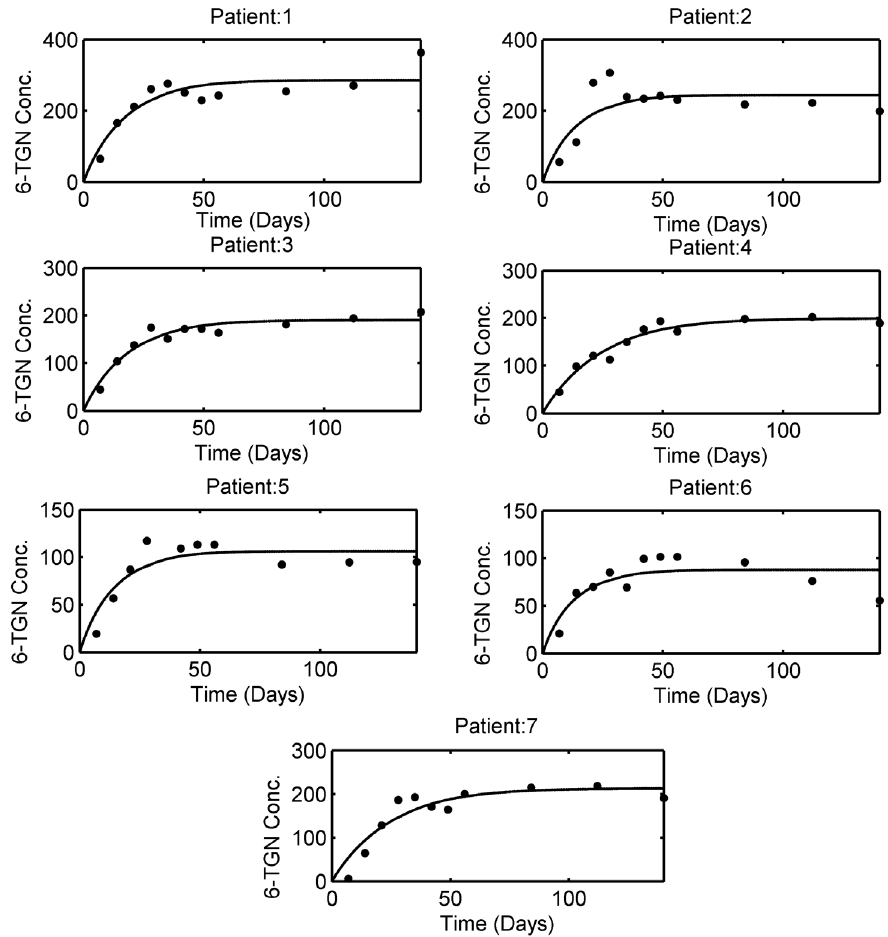
Figure 7. 6-MP model fit to individual patient data obtained from literature. Solid dots indicate the individual patient 6-TGN concentration and the solid line represents the model fit. Patient # 8 was omitted from analysis as it is observed that the dosing was discontinued or substantially lowered. The estimated patient-specific parameters are provided in Table 5.